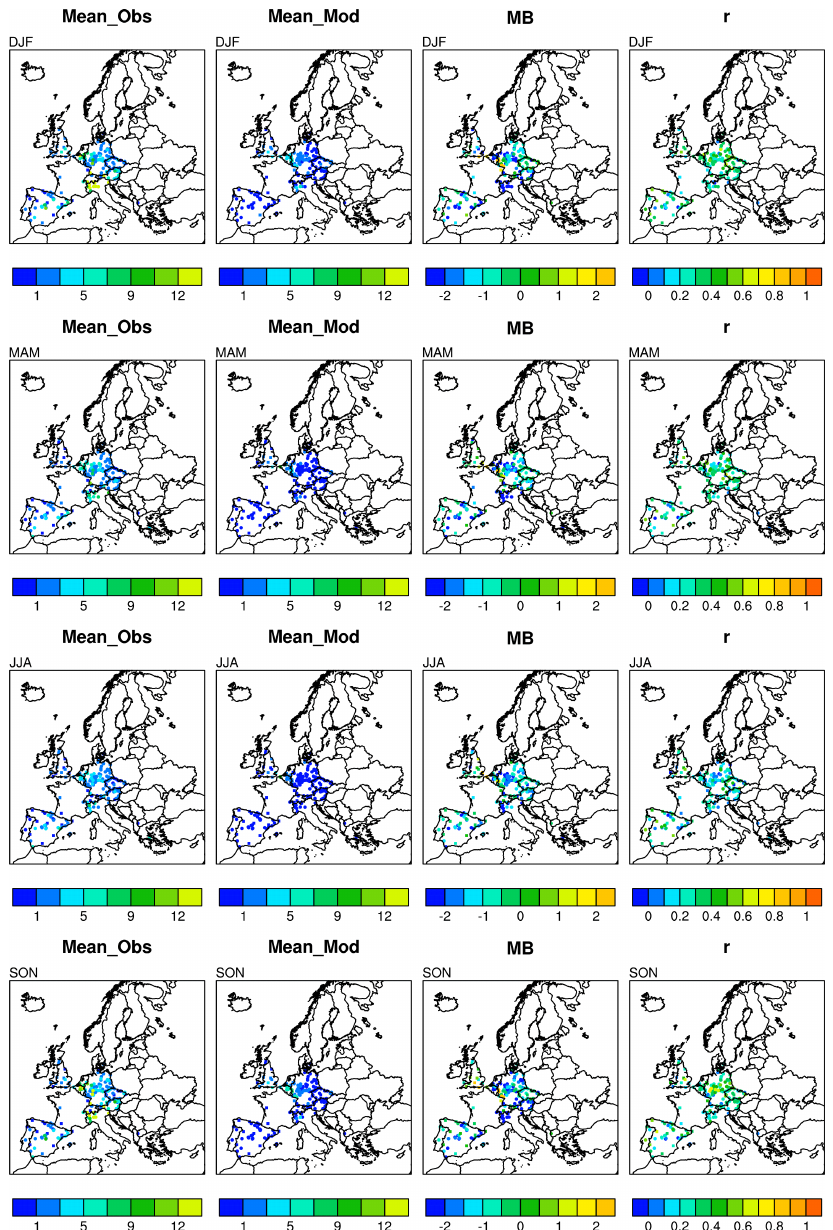
Figure 13. Seasonal average values of surface NO in µgm − 3 from hourly measurements at AirBase (circles) and EMEP (squares) stations, and modeled values from MOZART for corresponding locations. The MB and temporal correlation coefficient ( r ) for hourly values are also shown at the location of station